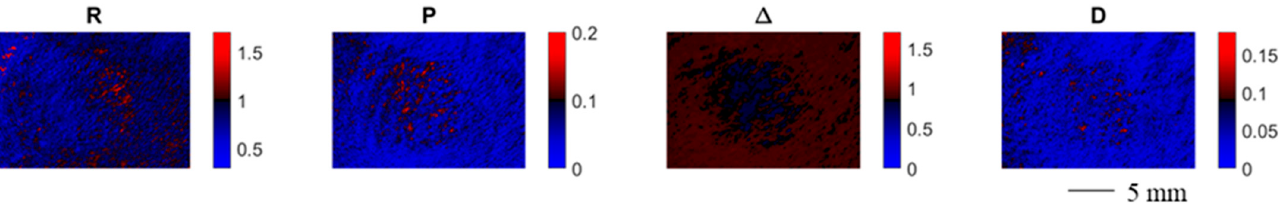
Figure 4. Spatially resolved polarimetric parameters for an exemplary contracture scar. Each polarimetric parameter provides a certain degree of contrast between the scarred and the healthy skin area.